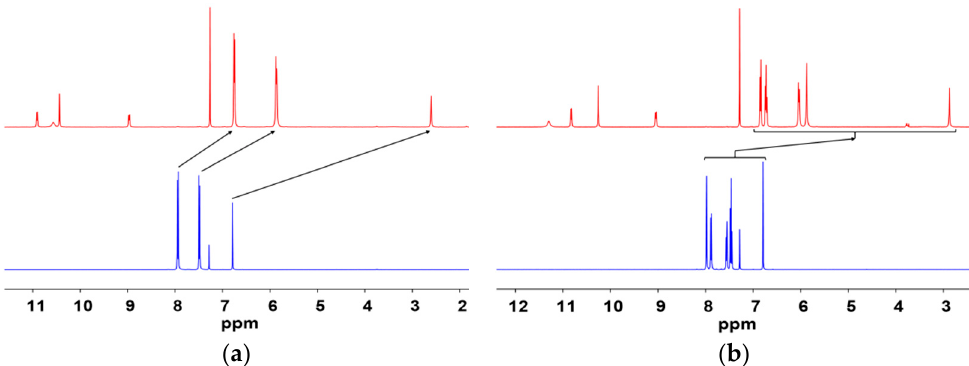
Figure 2. 1 H-NMR (400 Hz, CDCl 3 ) spectra of ( a ) [Eu( pp -dbm-Cl 2 ) 3 phen] (top) and pp -dbm-Cl 2 (bottom) and ( b ) [Eu( mm -dbm-Cl 2 ) 3 phen] (top) and mm -dbm-Cl 2 (bottom).